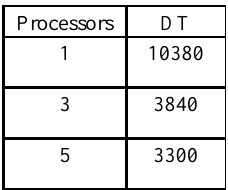
Table 5. Execution time (in seconds) with the DT algorithm